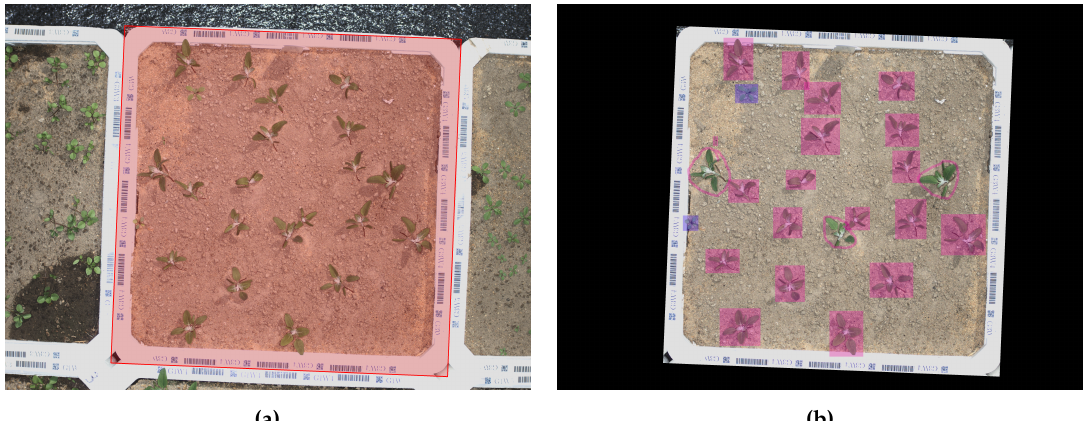
Figure 2. Annotation of images. ( a ) Annotation of primary polystyrene box in full RGB image. ( b ) Annotation of individual plants in the RGB image after removing all content outside the primary polystyrene box. The bounding boxes are annotated in RoboWeedMaPS’s online annotation tool. The rectangular annotation corresponds to the assisting annotation algorithm’s region proposals, while the three hand drawn annotations corresponds to manual corrections performed by a human annotator. The colours of the bounding boxes corresponds to different plant